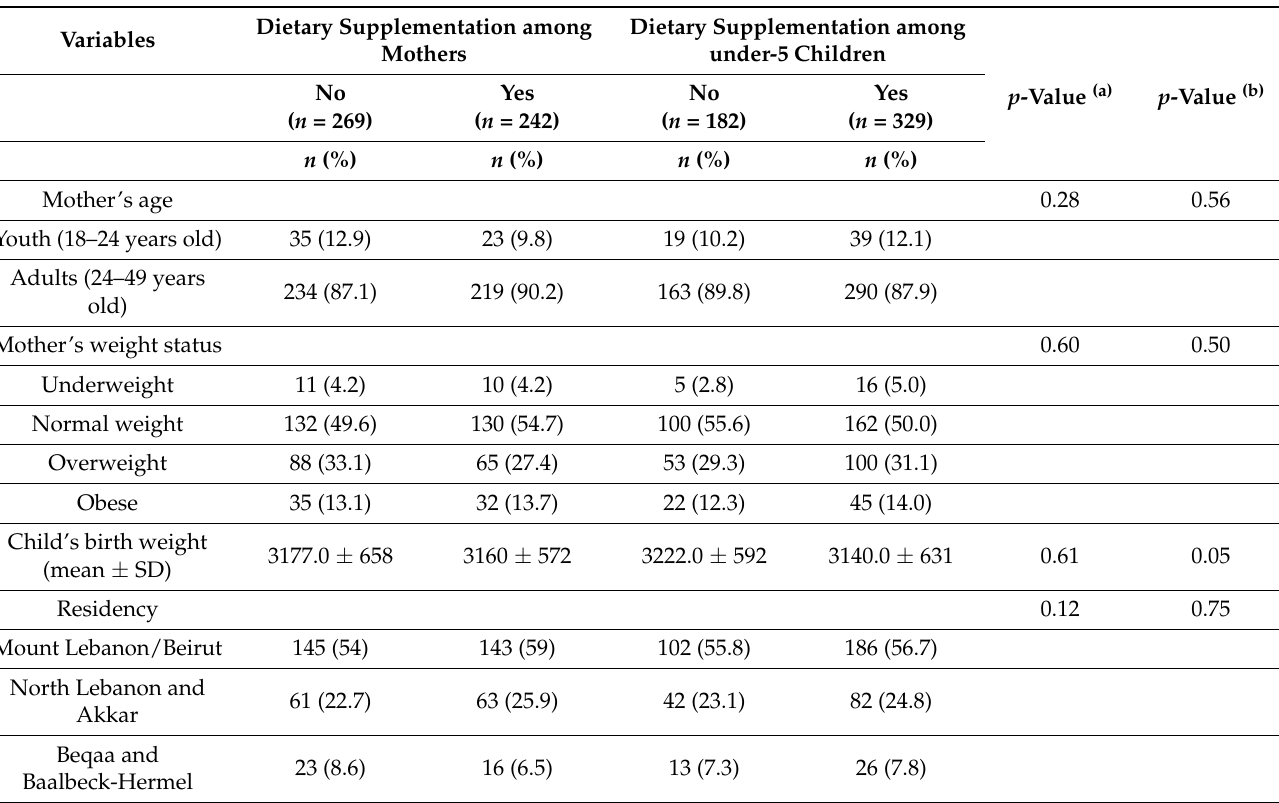
Table 5. The associations between study variables and oral dietary supplementation among mothers and their under-5